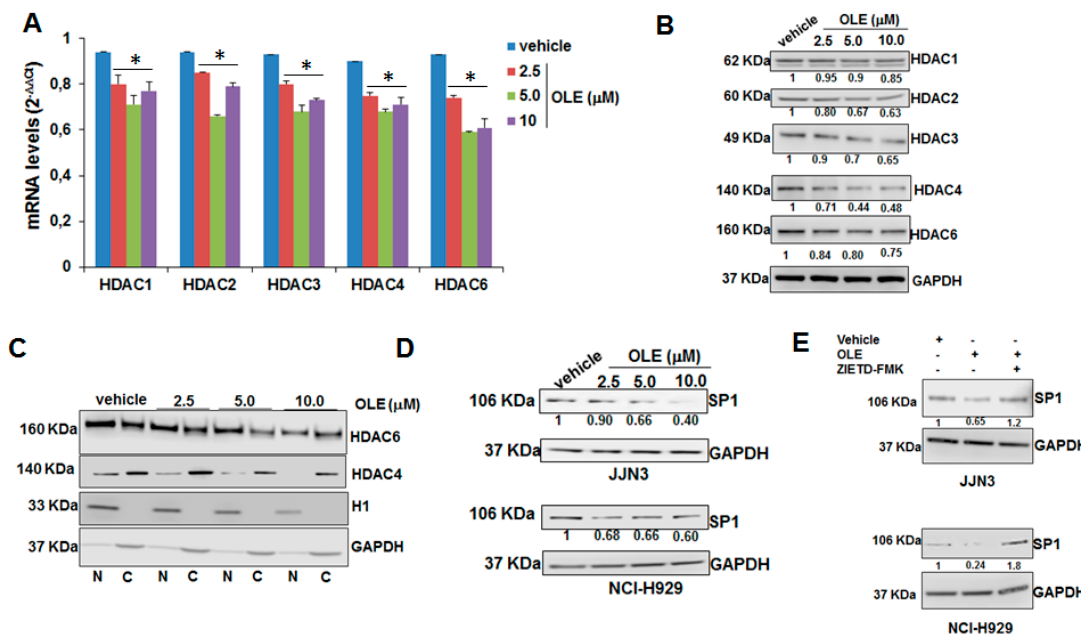
Figure 4. Oleacein targets HDACs. QRT-PCR ( A ) and WB analysis ( B ) of HDAC1, HDAC2, HDAC3, HDAC4, HDAC6 in JJN3 cells treated with oleacein for 24 hours; GAPDH was used as loading control. ( C ) WB analysis of HDAC4 and HDAC6 in nuclear (N) and cytoplasmic (C) protein fractions from JJN3 cells treated for 24 hours with oleacein; histone H1 and GAPDH were used as nuclear and cytoplasmic marker, respectively. ( D ) WB analysis of Sp1 in JJN3 cells treated with oleacein for 24 hours. ( E ) WB analysis of Sp1 in JJN3 cells treated with 5.0 µM oleacein with or without 20.0 µM Z-ITED-FMK; GAPDH was used as loading control. * p < 0.05 as compared to vehicle-treated cells.